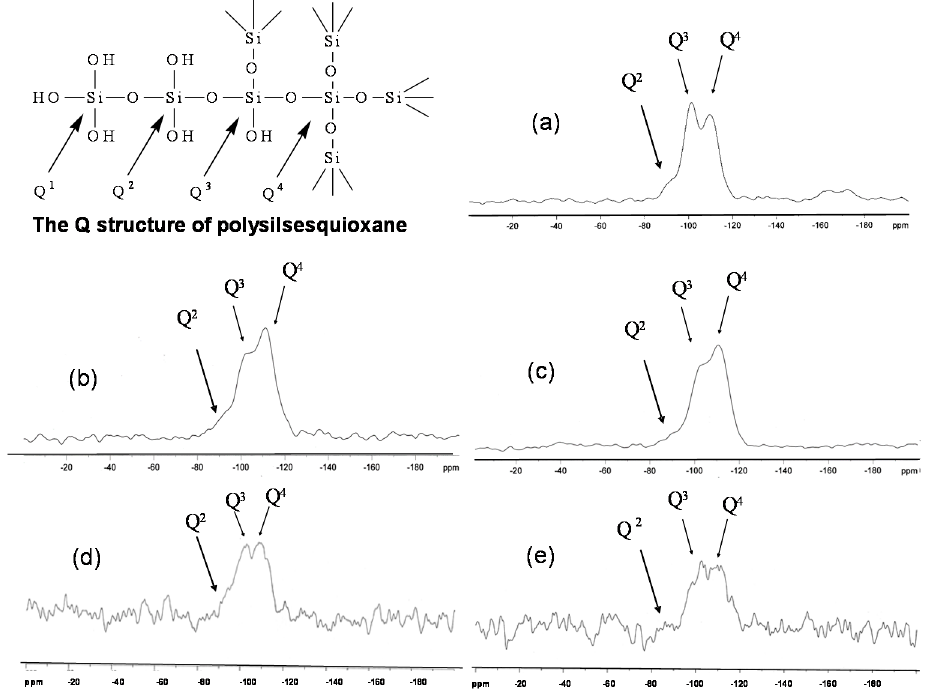
Figure 3. The solid-state 29 Si NMR spectra of silica and MWCNT-grafted silica nanohybrids: ( a ) neat silica; ( b ) MWCNT-COOH-silica; ( c ) MWCNT-COCl-silica; ( d ) MWCNT-NH 2 -silica; and ( e ) MWCNT-OH-silica.